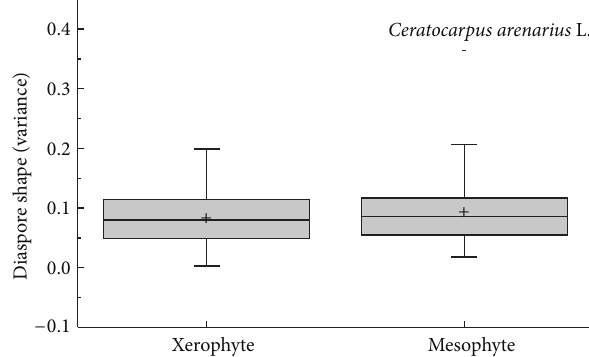
Figure 7: Box plots showing mean (+), median (—), quartiles, and outliers (-) of diaspore shape (variance) of 150 species grouped by different dispersal syndromes.